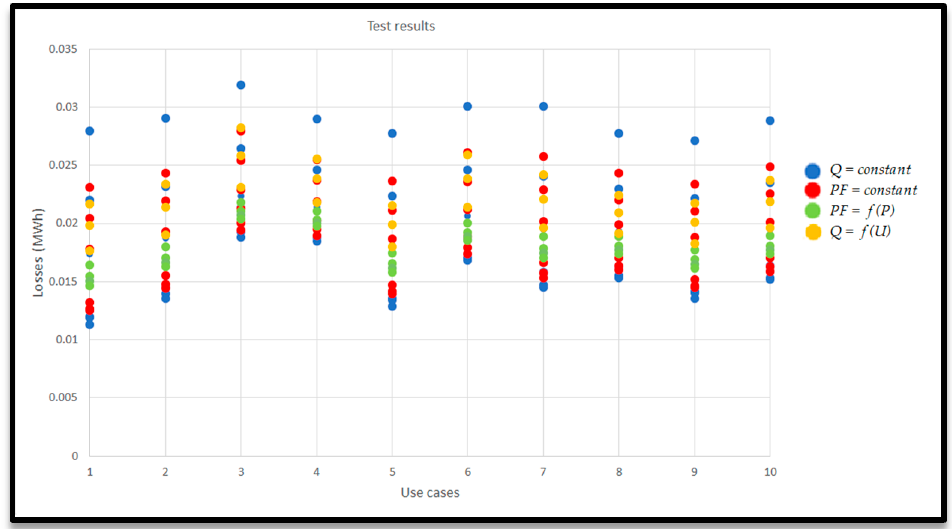
Figure 14. Results all controls: Losses.